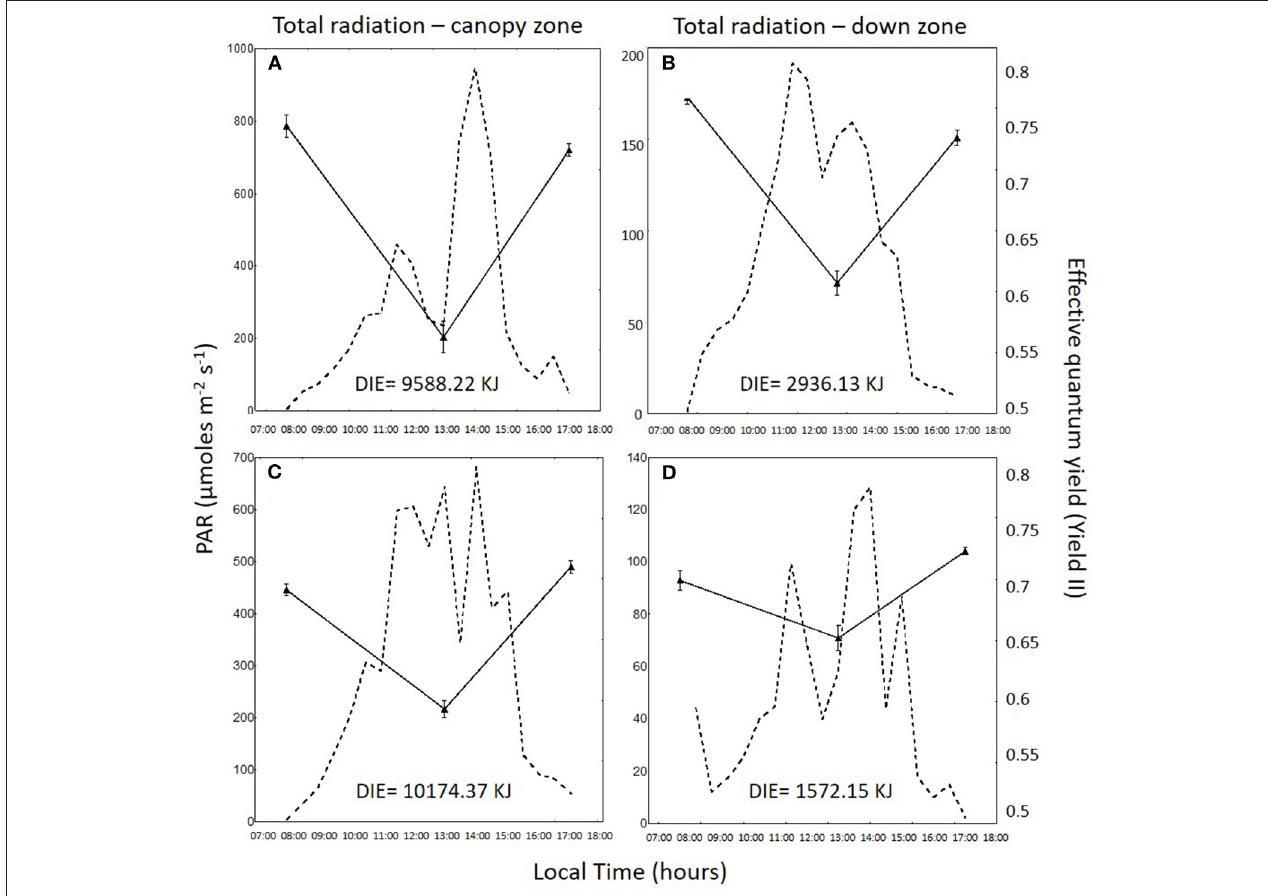
FIGURE 2 | Photosynthetically active radiation (PAR: 400–700nm, in µ mol photons m − 2 s − 1 , dotted lines) and the effective quantum yield (Y II ) in Macrocystis pyrifera fronds (continuous lines) in the total radiation treatment during the first daily cycle under the canopy zone (A) and the down zone (B) ; likewise, in the second daily cycle under the canopy zone (C) and the down zone (D)